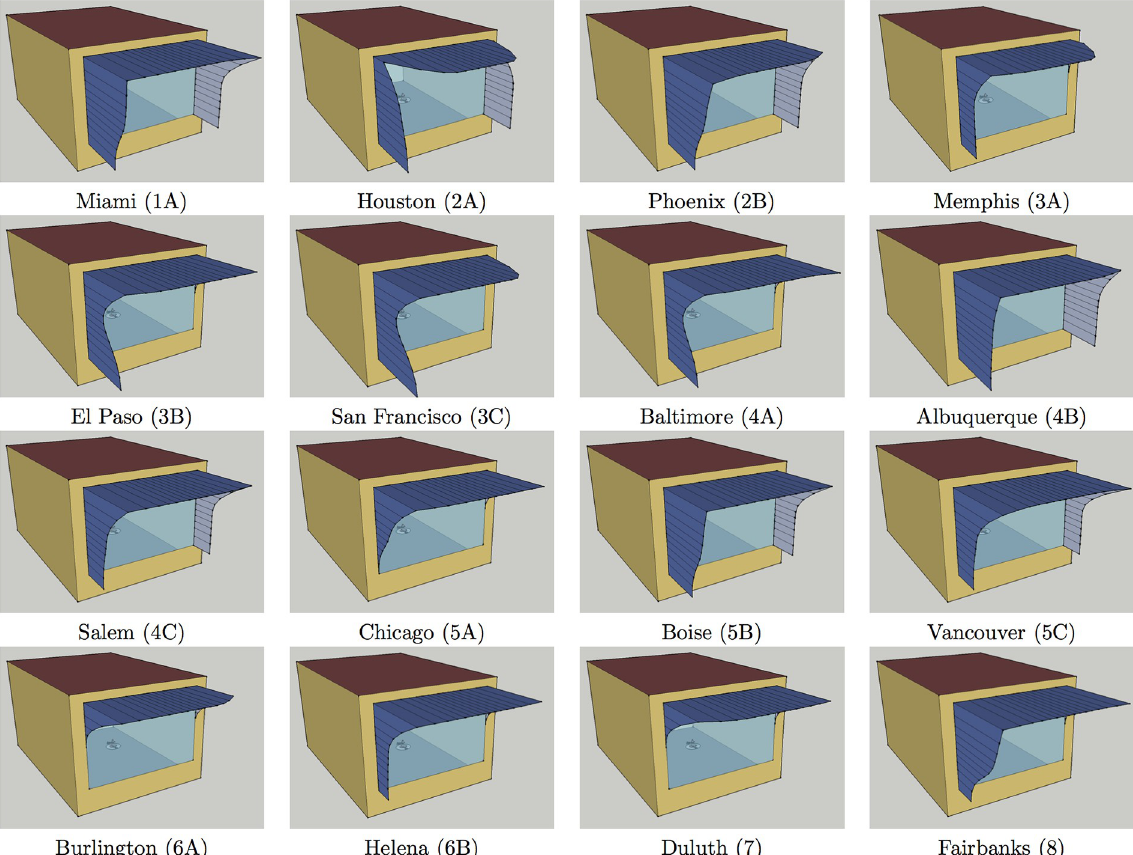
Fig 6. Sketchup visualisations of cellular office model with optimal simplified shading for each location.